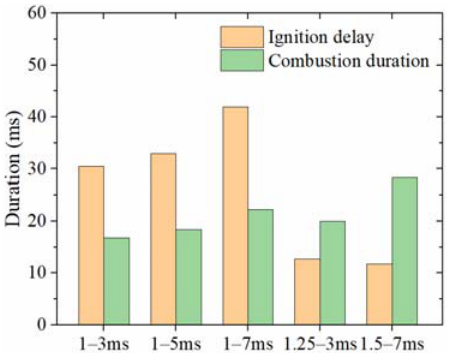
Figure 15. Histograms of ignition delay and combustion duration for different spark timings and prechamber global equivalence ratios.